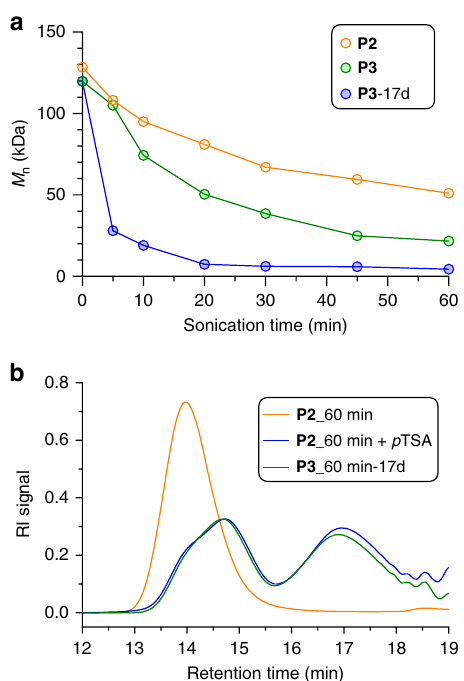
Fig. 6 Mechanical degradation of P2 and P3, and mechanically regulated degradability of P2. a Comparison of M n evolution over sonication time. Orange dots: P2 polymer; blue dots: P3 polymer analyzed immediately after sonication; green dots: P3 polymer analyzed after sonication and further 17 days standing time. b GPC overlay of P2 polymer after sonication, P2 polymer after sonication and further p TSA treatment at room temperature overnight, and P3 polymer after sonication and additional 17 days standing time. P3 _60min-17d is normalized to the peak intensity of P2 _60min + p TSA.